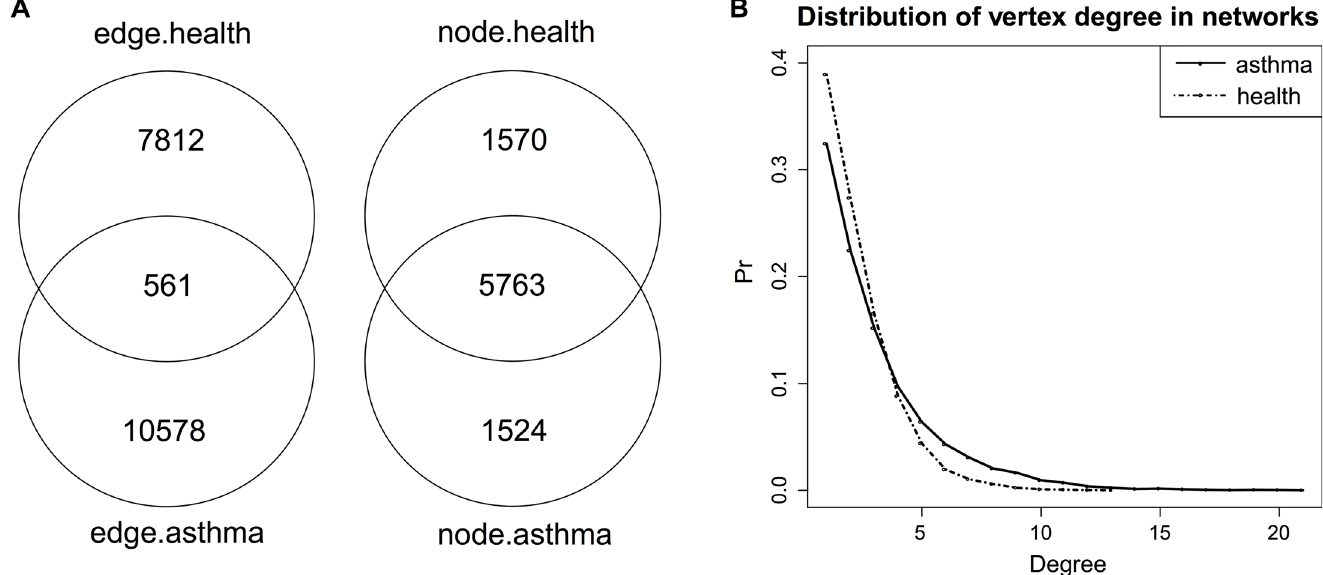
Fig 2. Comparing gene association networks under asthmatic and healthy conditions. A) Venn diagram of the edges and nodes in the asthmatic and healthy networks. B) Distributions of vertex degree in the two